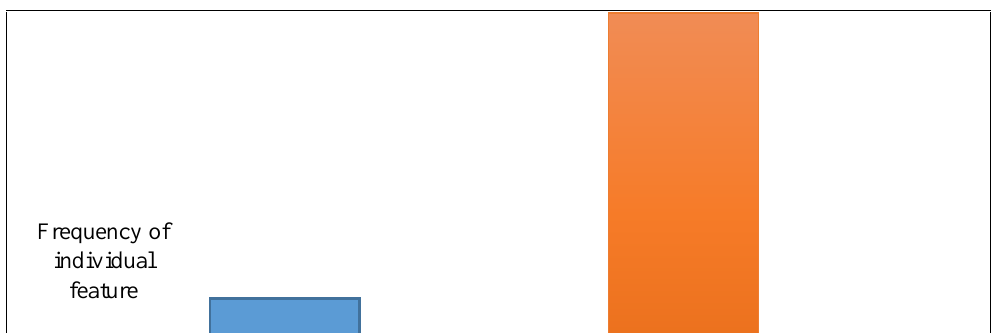
Figure 6. frequency of features in Pareto distribution